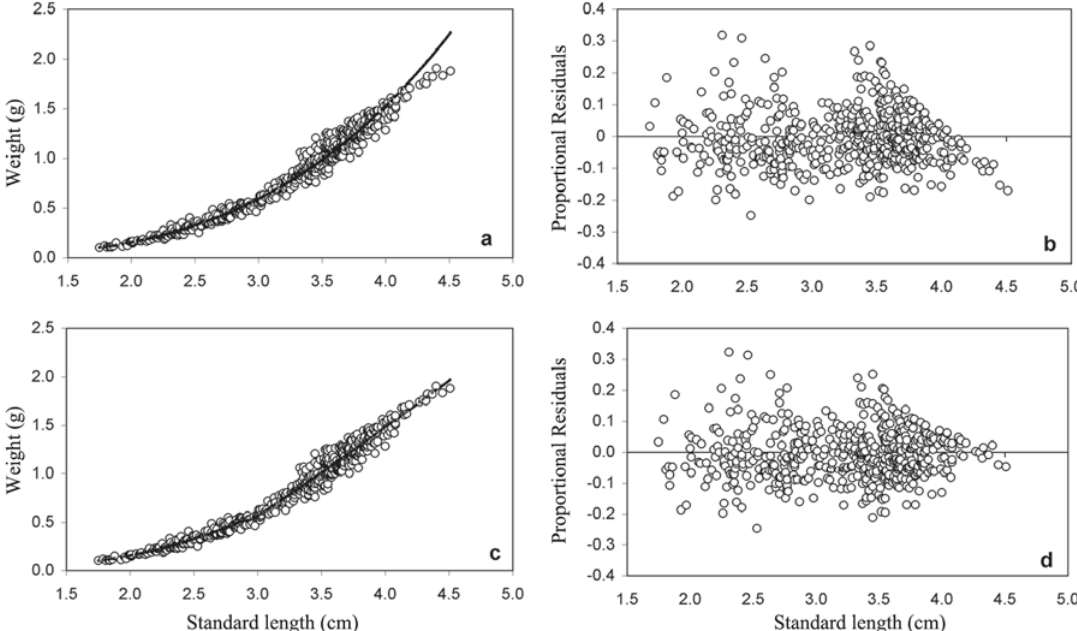
Fig. 2. Weight/length relationship for Cheirodon ibicuhiensis ( a ); proportional residuals resulting from Huxley´s adjustment ( b ); weight/length relationship and proportional residuals distribution according to the polyphasic growth model ( c and d ,